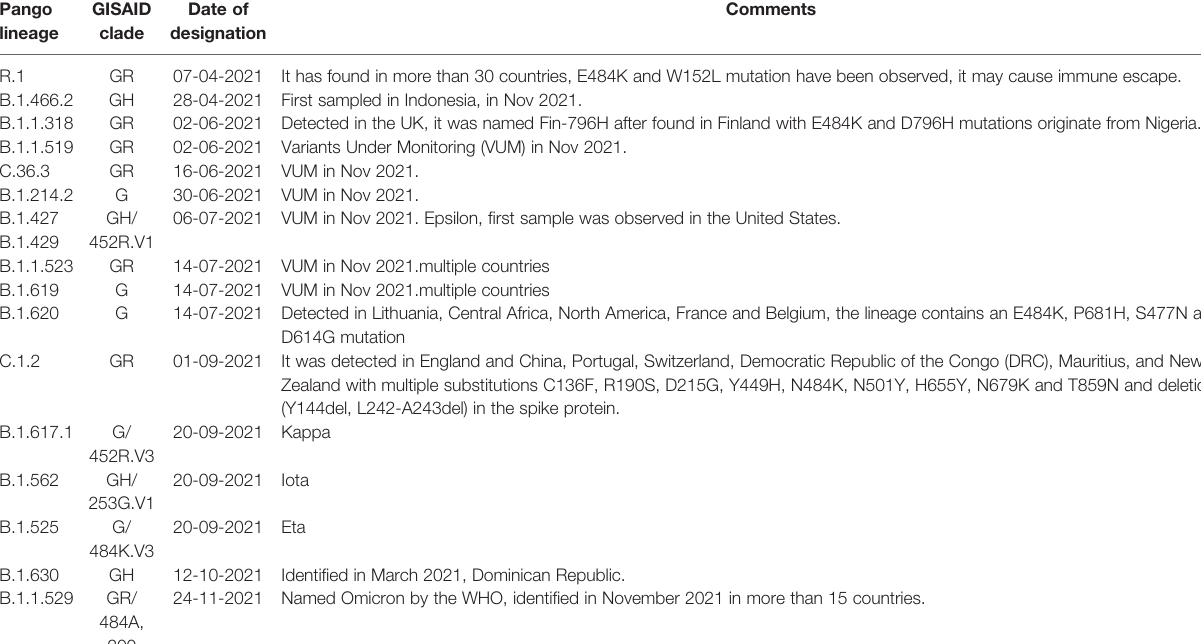
TABLE 3 | List of variants for further